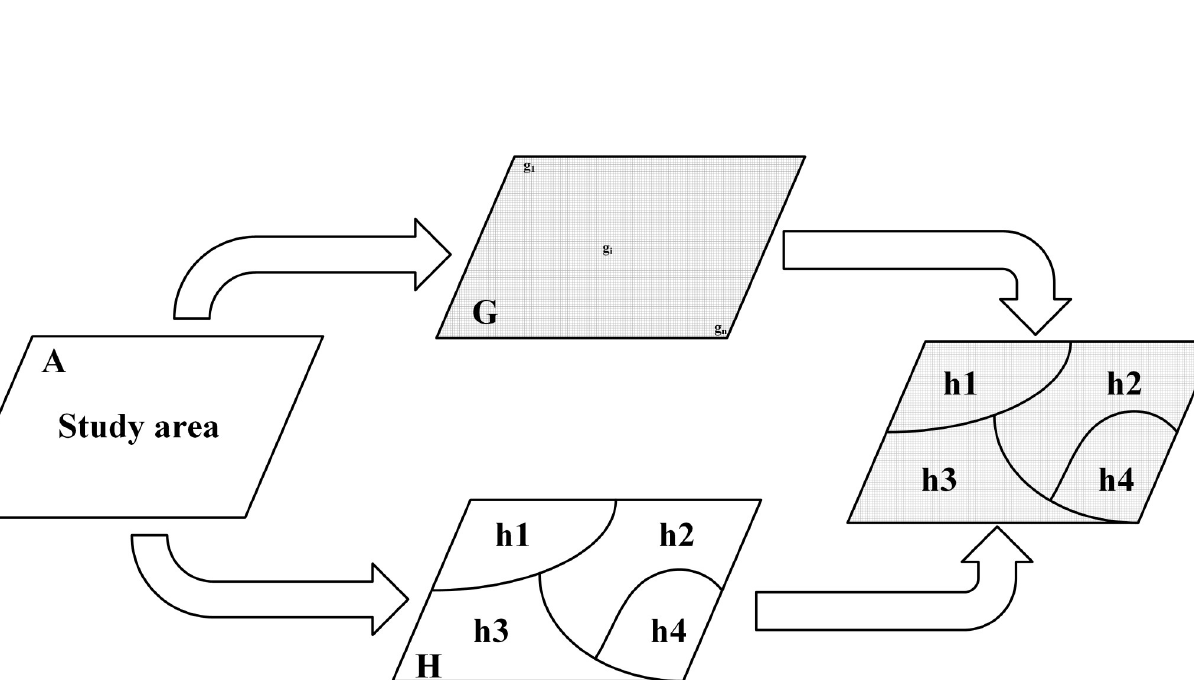
PLOS NeglectedTropical Diseases | https://doi.org/10.1371/journal.pntd.0009547 July 12, 2021 7 /